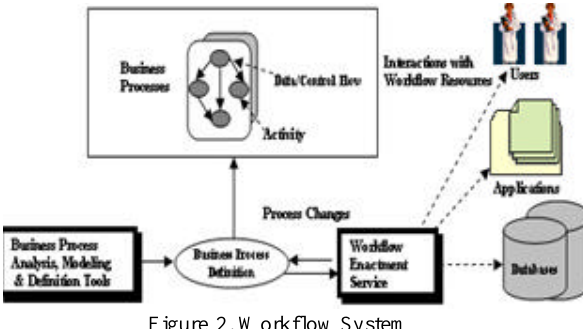
Figure 2. Workflow